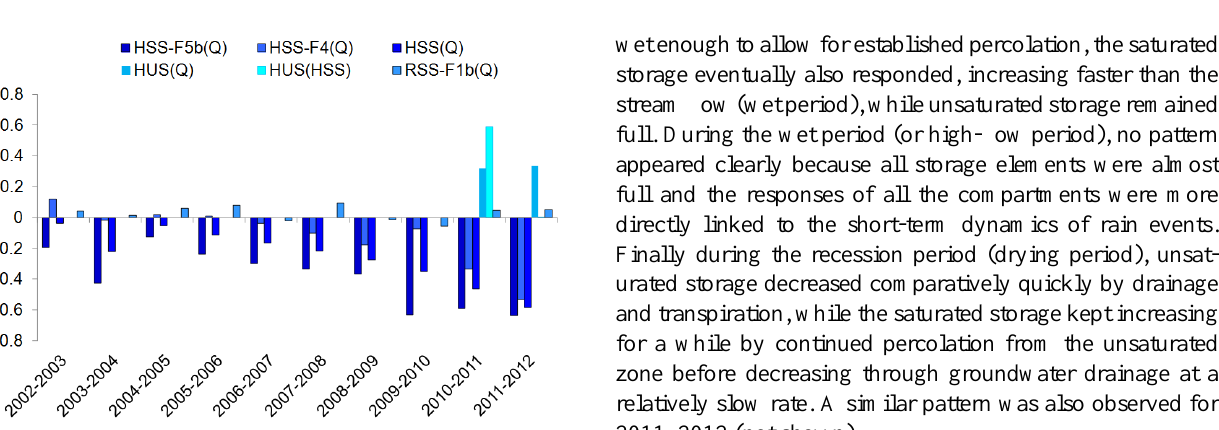
Figure 5. Annual hysteresis indexes (HI) computed for the piezometers in the Kerrien catchment from 2002 to 2012. F5b is located upslope, F4 midslope and F1b downslope in the ripar- ian area. RRS(Q) is the hysteresis between stream flow and ripar- ian saturated-zone storage (measured at F1b). HSS-F5b(Q), HSS- F4(Q) and HSS(Q) are hystereses between stream flow and ups- lope (at F5b), midslope (at F4) and hillslope (average of F5b and F4) saturated storages respectively. HUS(Q) is the hysteresis be- tween stream flow and hillslope unsaturated storage (HUS) (com- puted from the average of normalized volumic moisture sensors in profiles sB1 and sB2), and HUS(HSS) is that between the hillslope unsaturated- and saturated-zone storage (average of F5b and